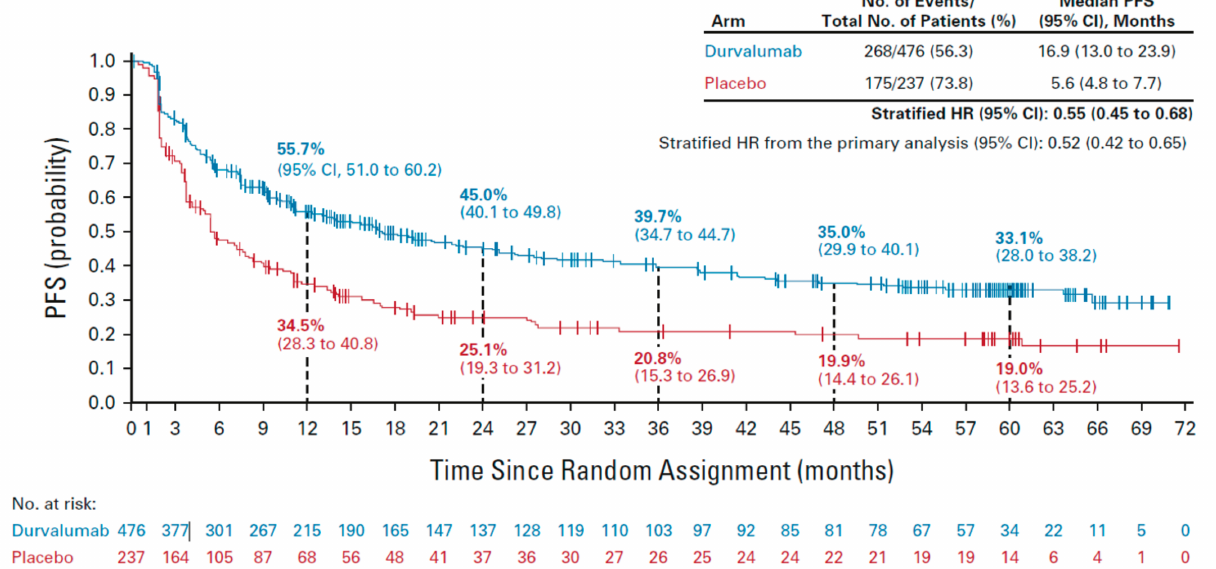
Figure 1. Progression-free survival in the ITT population of the PACIFIC trial. Vertical dashed lines indicate annual landmarks; the associated values represent the PFS rate at each timepoint. PFS was defined as the time from random assignment to the date of the first documented event of tumor progression or death in the absence of disease progression. Patients who had not progressed or died at the time of data cut-off were censored at the time of their last evaluable RECIST assessment; however, if a patient progressed or died after ≥ 2 missed visits, they were censored at the time of the latest evaluable RECIST assessment before the two missed visits. CI, confidence interval; HR, hazard ratio; RECIST, Response Evaluation Criteria in Solid Tumors; PFS, progression-free survival [13]. Figure used with permission from Wolters Kluwer Health, Inc. The Creative Commons license does not apply to this content. Use of the material in any format is prohibited without written permission from the publisher, Wolters Kluwer Health,